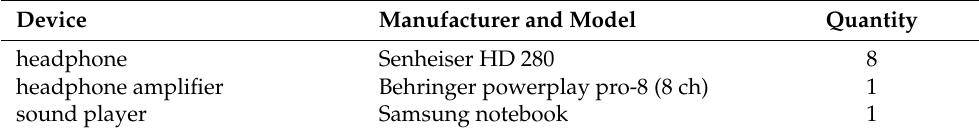
Table 7. Equipment list used for the speech intelligibility test.